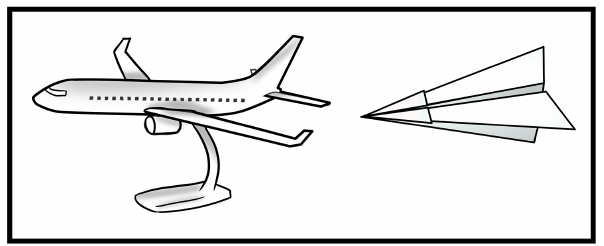
Figure 6. Which model will fly? (drawing by Steph’s